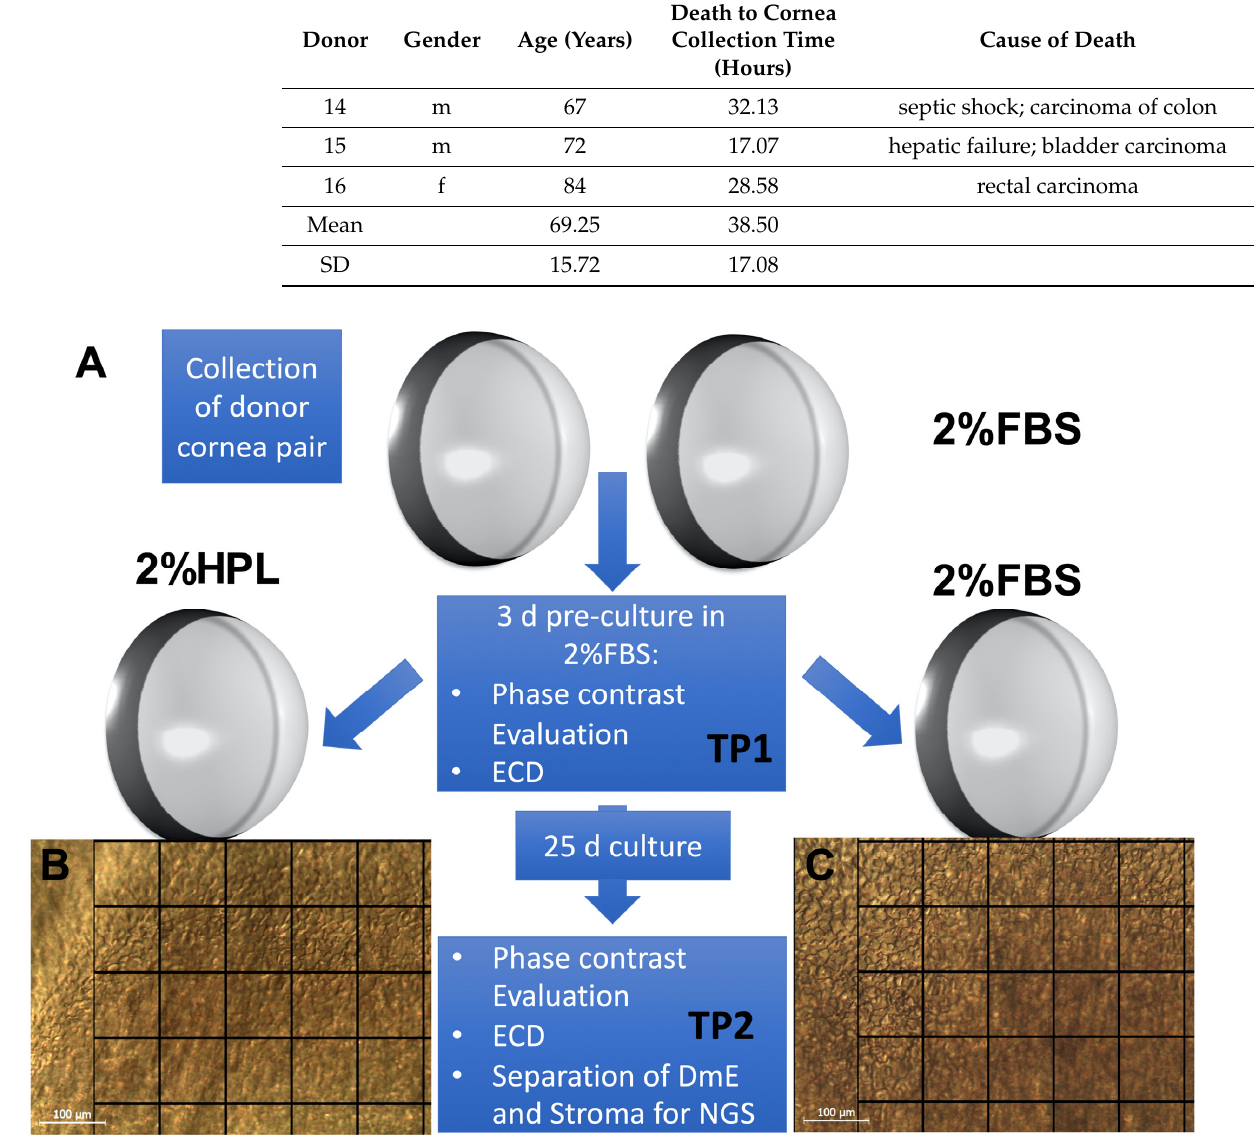
Figure 1. ( A ) Experimental workflow. The 32 corneas (16 pairs) from 16 donors were collected using corneoscleral excision and pre-cultured in 2% FBS medium (2%FBS). After 3 days (TP1) and evaluation of cell density and morphology, the pairs were split up into either 2%FBS or 2% HPL medium (2%HPL). After 25 days of differential culture conditions (time point TP2), phase contrast evaluation (donor 3 showing a healthy corneal endothelium layer in 2%HPL ( B ) and 2%FBS ( C ), a square equals 100 × 100 µm) was repeated, stroma and Descemet membrane/endothelium (DmE) were separated and processed for next generation sequencing (NGS, 15 pairs). Table 1. Gender, age, death to cornea collection time and cause of death of the cornea donors included in this study.